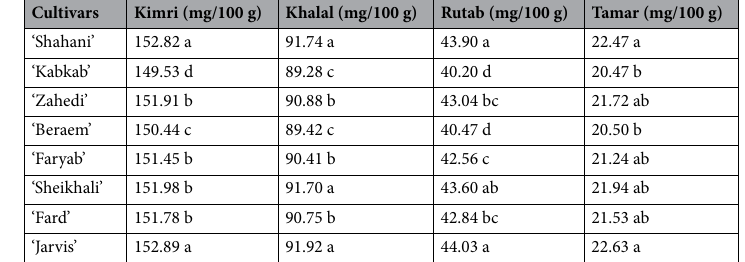
Table 2. Total phenol content of ‘Piarom’ date fruit in kimri, khalal, rutab and tamar stages after pollination with eight pollinating cultivars. Different letters within columns indicate significant differences according to Duncan’s multiple range test (p <